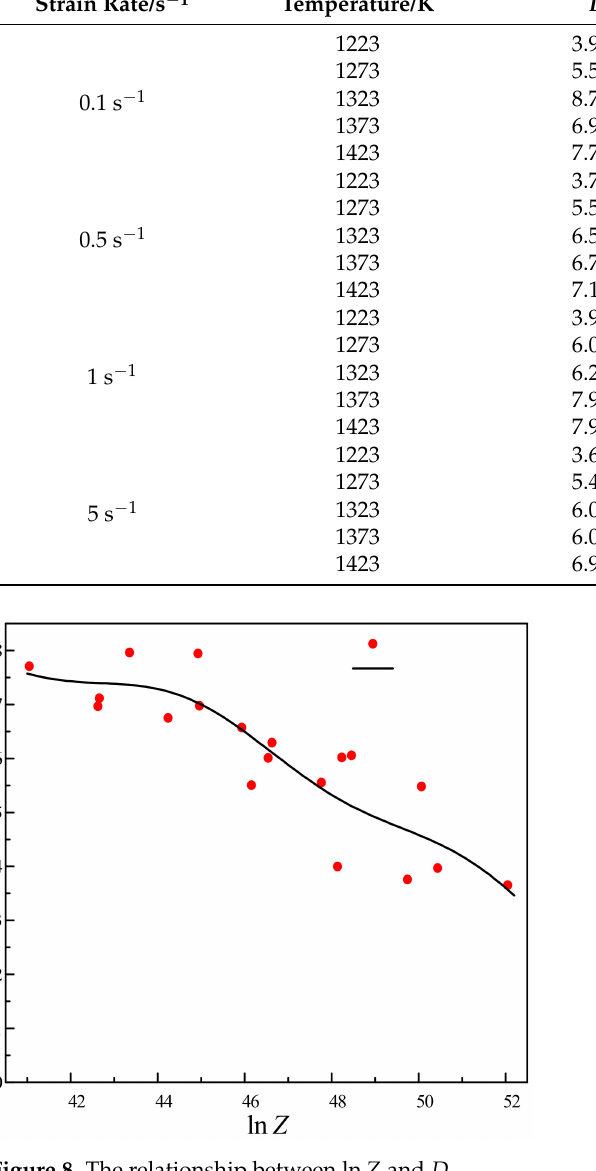
Figure 8. The relationship between ln Z and D c